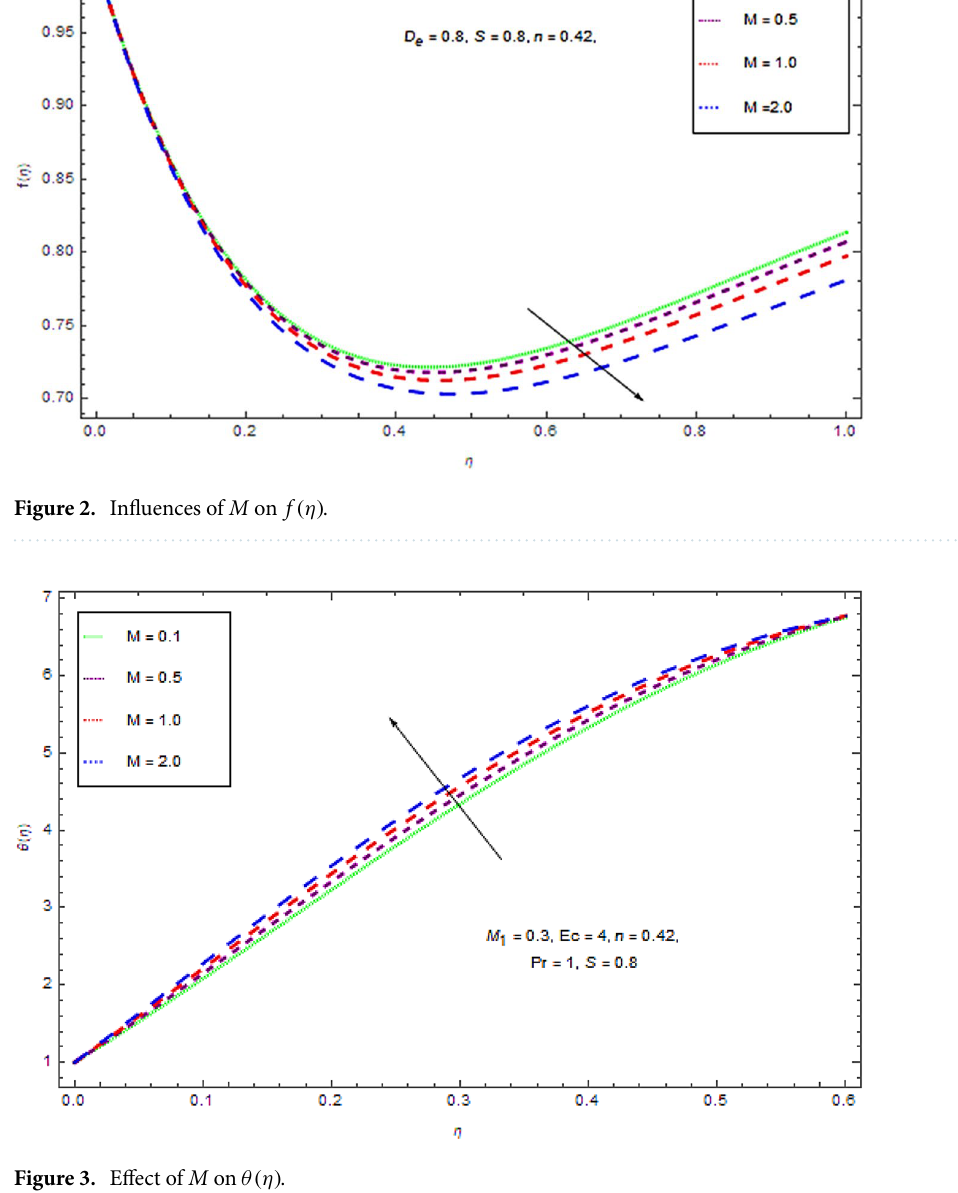
Figure 3. Effect of M on θ(η)